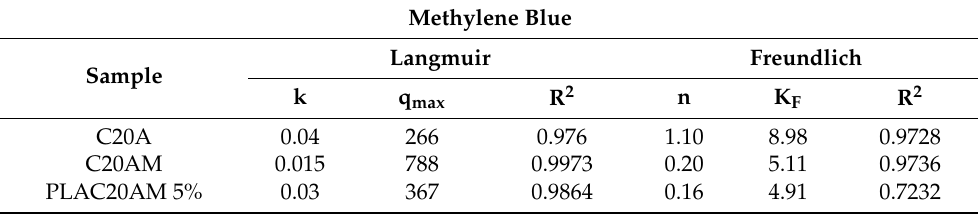
Table 6. Parameters of the isotherm constants and correlation coefficients were calculated for MB adsorption.